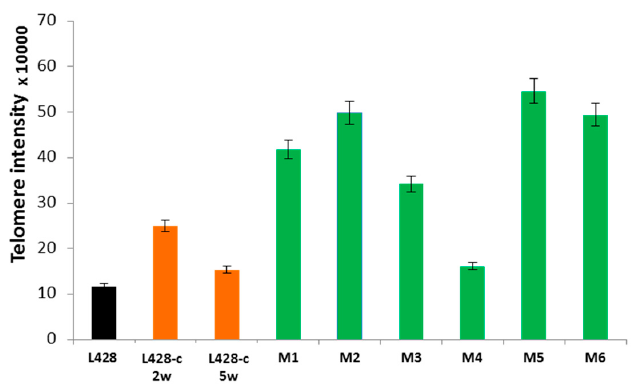
Figure 6. Comparison of telomere length in the L428 cell line, L428-c subline expanded in vitro for two or five weeks, and HL cells recovered 16 and 32 weeks, respectively, from the livers of mice (M1–M6). All experiments were performed in triplicate and 200 metaphases were scored. The mean ± SEM is shown.